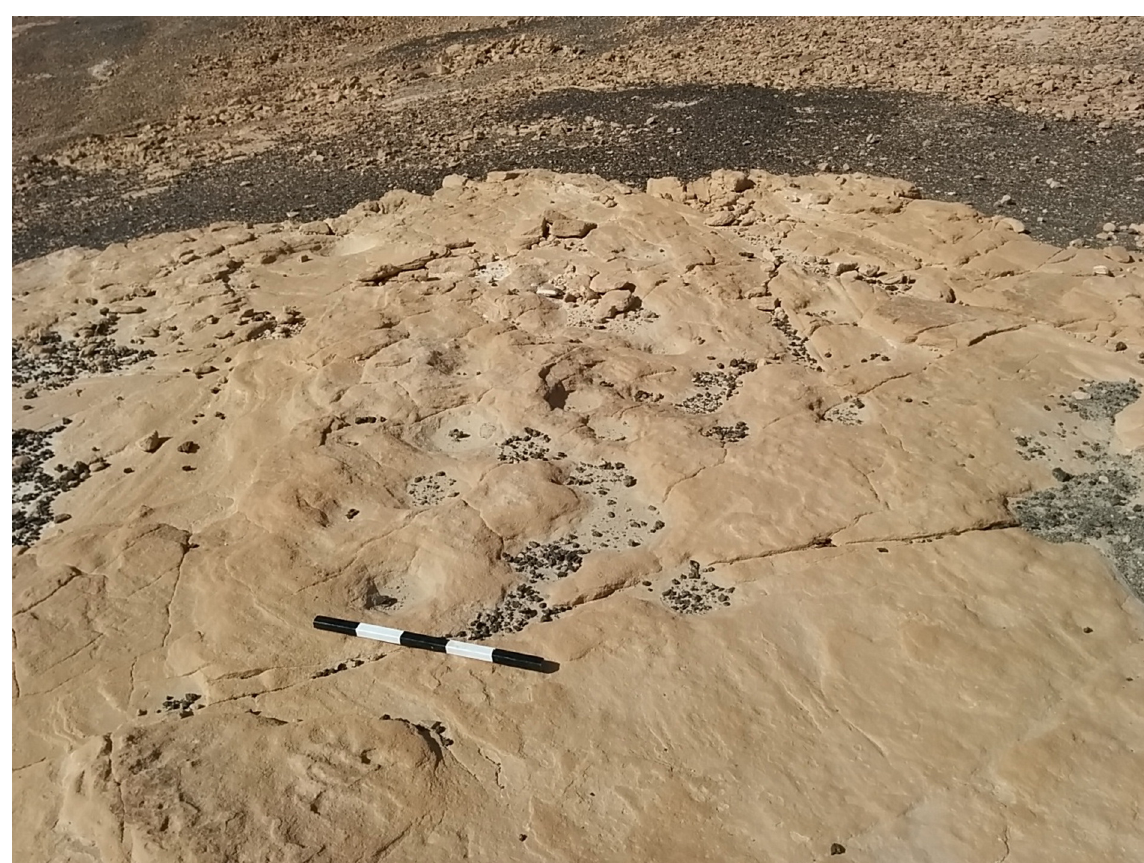
Figure 12. Bedrock mortars and cup marks on the eastern side of Site 34; looking Journal of Lithic Studies (2016) vol. 3, nr. 3, p. 191-220 doi:10.2218/jls.v3i3.1678